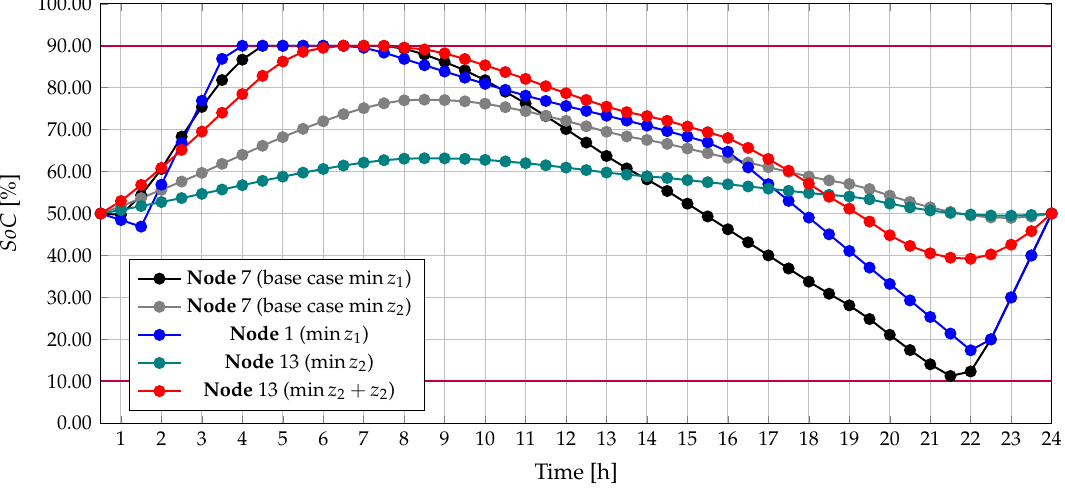
Figure 8. Behavior of battery type 1 in its different